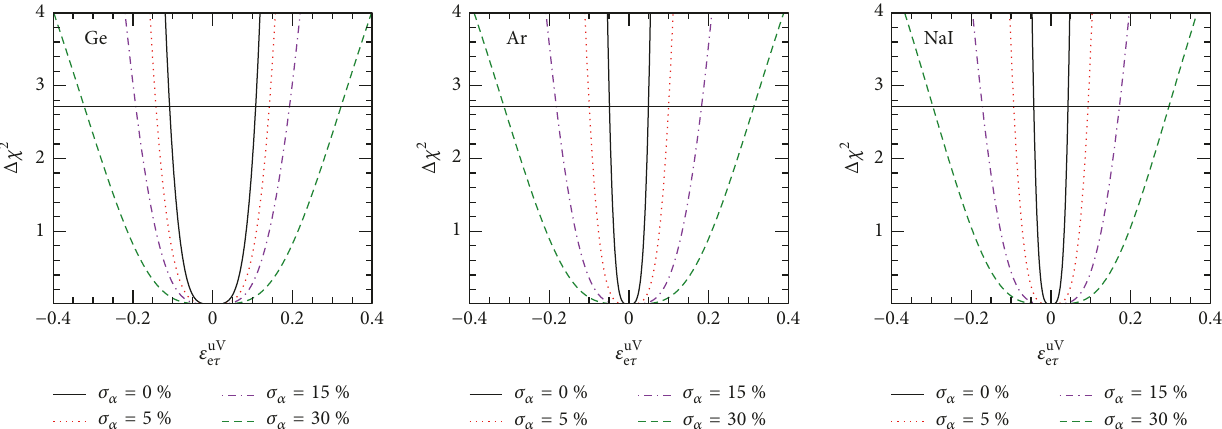
Figure 3: Expected sensitivity to 𝜀 𝑢𝑉 𝑒𝜏 for the different detectors under consideration: Germanium, Argon, and NaI, respectively. Again, the different curves are for the ideal case of 𝜎 𝛼 = 0 % with 100 % efficiency and a background error of 𝜎 𝛽 = 0 % (solid), for 𝜎 𝛼 = 5 % with 50 % efficiency and a background error of 𝜎 𝛽 = 10 % (dotted), for 𝜎 𝛼 = 15 % with 100 % efficiency and a background error of 𝜎 𝛽 = 10 % (dashed- dotted), and 𝜎 𝛼 = 30 % with 100 % efficiency and a background error of 𝜎 𝛽 = 10 % (dashed); see text for details. The horizontal line indicates the 90 % CL.